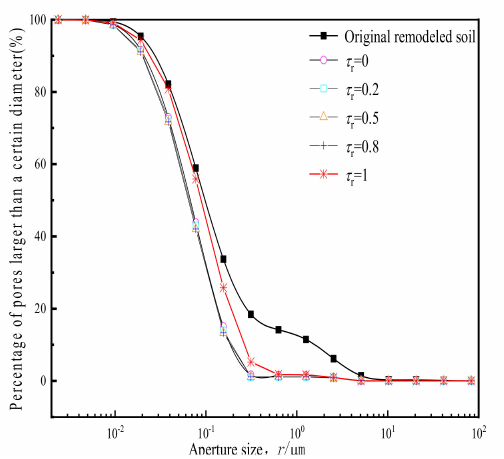
Figure 14. Accumulated pore size distribution before and after cyclic loading. In it, the abscissa indicates the pore sizes, and the ordinate indicates the proportion of pores. It can be seen that, for different reshaped clay samples before cyclic loading, the proportion of pores with a diameter of > 1 µ m account for about 15%. After cyclic loading, small pores increased in number and large pores essentially disappeared. The accumulative distribution curve of pores after loading approached each other, and the proportion of pores of 1 µ m did not exceed 1% in any of the samples.